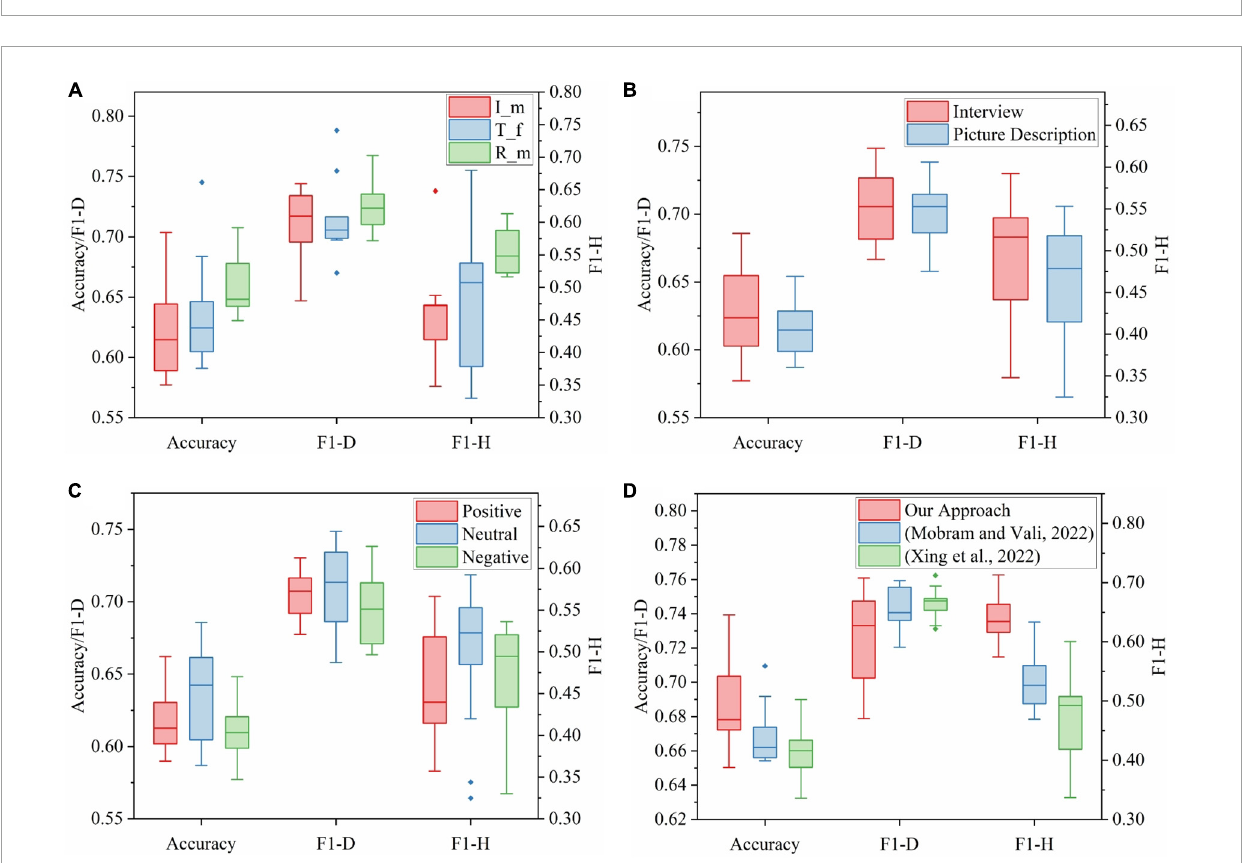
FIGURE6 (A) The result comparison of each extractor based on the most matching feature set in nine speech tasks using SVM. (B) The result comparison of speaker embeddings in speech tasks of different genres using SVM. (C) The result comparison of speaker embeddings in speech tasks of